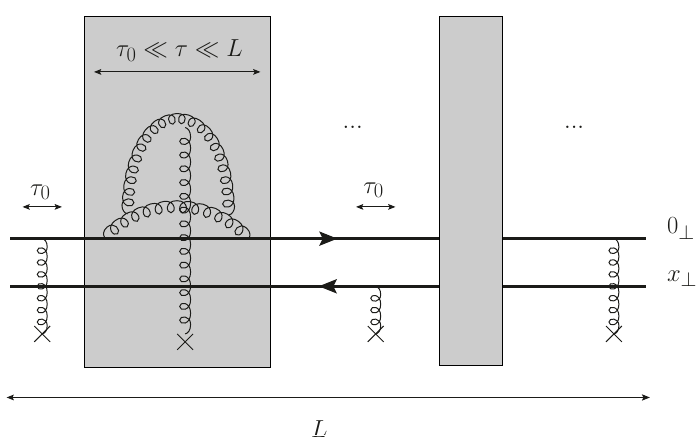
Figure 2. An illustration of multiple radiative corrections considered in this paper. Each block represents a tower of gluon fluctuations triggered by a single scattering with a medium constituent, with strongly decreasing lifetime and transverse momentum along the cascade (so the transverse size of a gluon increases from the parent to its daughter). The exponentiation resums several such blocks over the path length L of the incoming hard effective dipole with transverse size x ⊥ ∼ 1 /k ⊥